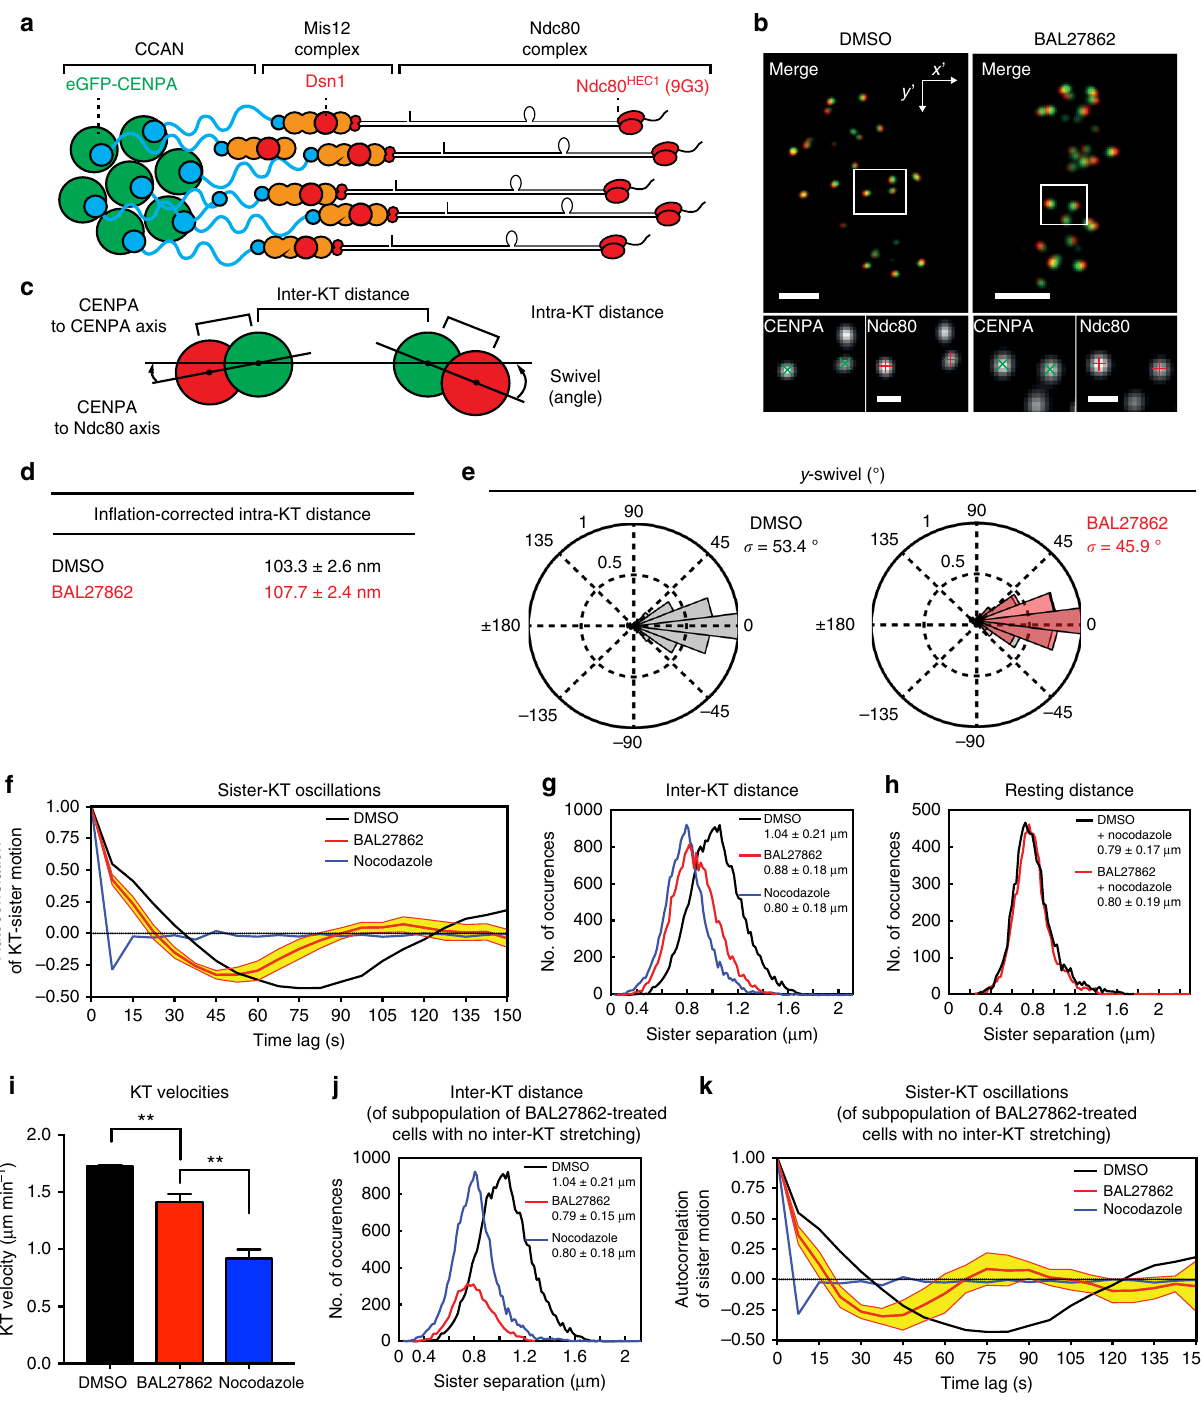
(Fig. 2f): 45 the position of the fi rst minimum indicates the